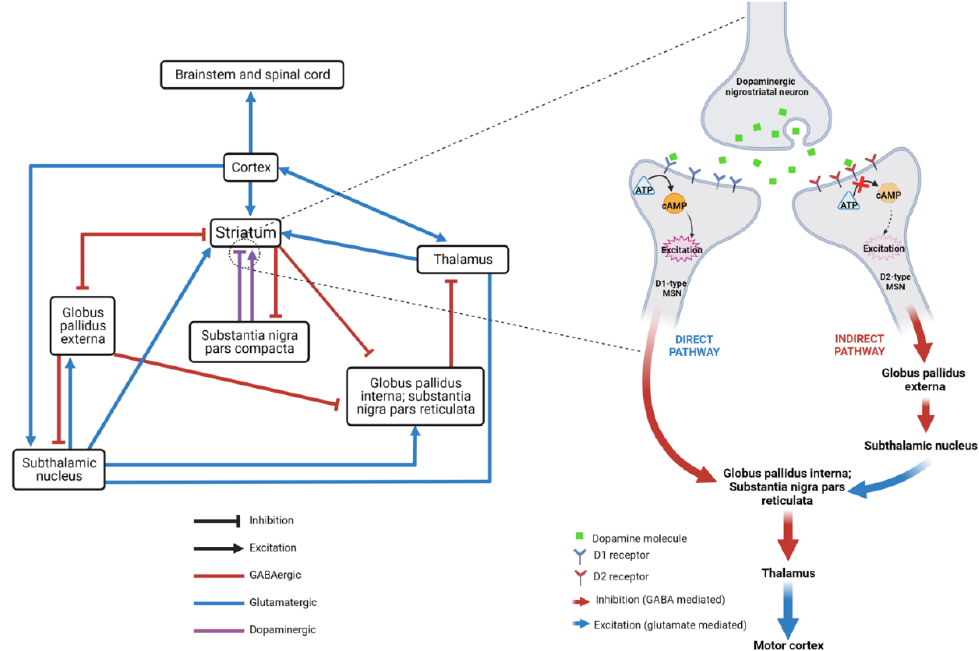
Figure 1. Schematic representation of direct and indirect pathways of the basal ganglia. Left: The direct and indirect pathways regulate voluntary movement and form a key part of the cortico-basal ganglia-thalamic network. The striatum receives inputs including dopaminergic fibres from the substantia nigra, as well as GABAergic (inhibitory) inputs from the globus pallidus pars externa and glutamatergic (excitatory) inputs from the cortex, thalamus and subthalamic nucleus. In turn, it provides inhibitory output via GABergic medium spiny neurons (MSNs) to the globus pallidus pars interna and externa and the substantia nigra. The balance of these outputs determines the relative activity of the direct (prokinetic) and indirect (antikinetic) pathways by modulating thalamic excitatory output to the motor cortex. Right: Dopamine in the striatum has opposite effects depending on whether the postsynaptic MSN expresses D 1 or D 2 receptors, exciting the former—which contribute to the direct pathway—and inhibiting the latter—which contribute to the indirect pathway.